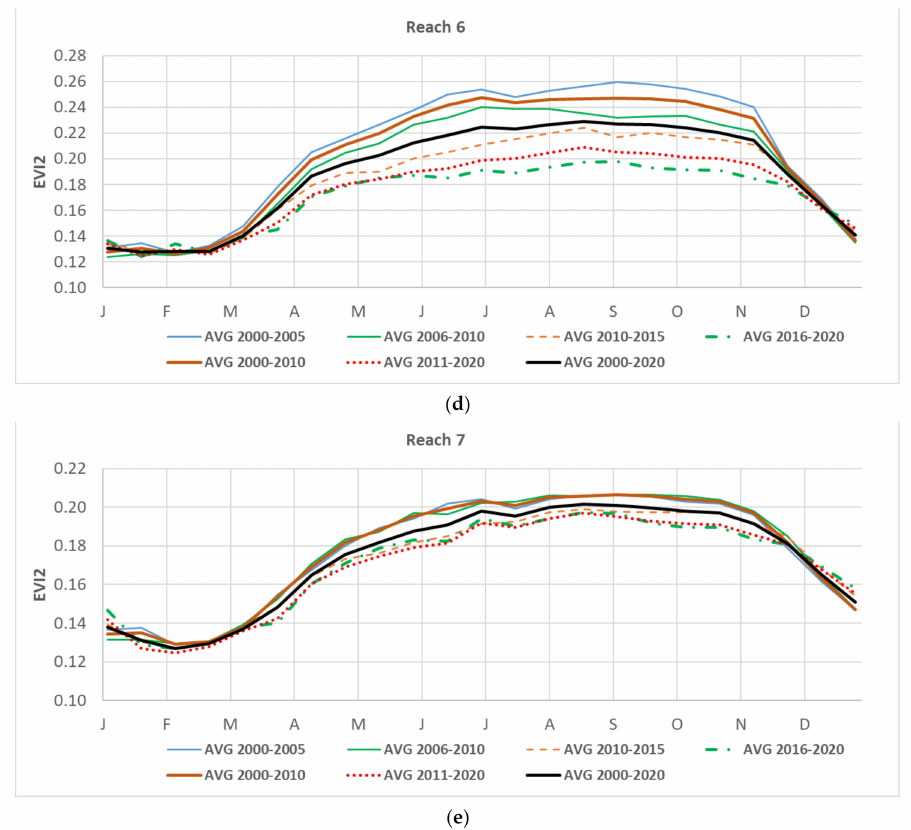
Figure 2. ( a – e ). EVI2 time-series information for the five reaches, R3–R7 (Figure 2a–e) for the full year with months on the x -axis (J–D), for years 2011 to 2020 individually and averaged by two decades, 2000–2010 and 2011–2020, and the full 21-year period, 2000–2020 as well as the two recent five-year periods, 2010–2015 and